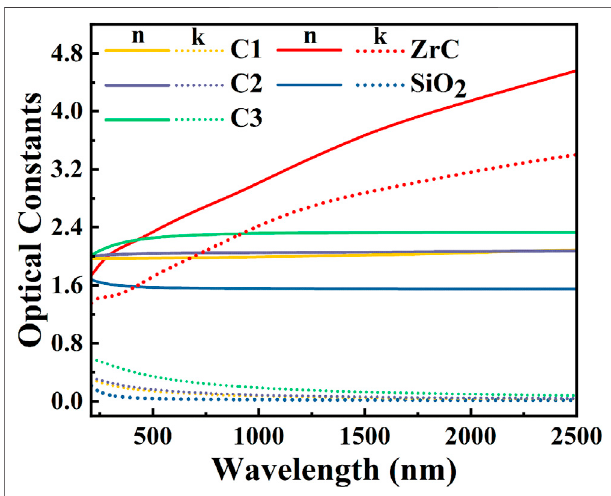
FIGURE1| Refractiveindex(n)andextinctioncoef fi cient(k)ofZrC,SiO 2 , and ZrC-Al 2 O 3 ceramic composites (C1, C2, and C3) with different volume